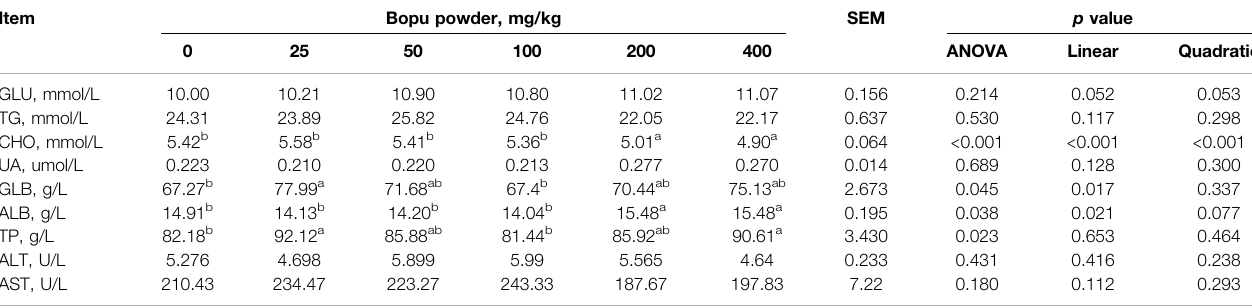
TABLE 3 | Effect of dietary Bopu powder supplementation on serum biochemical parameters indices of laying hens. Item